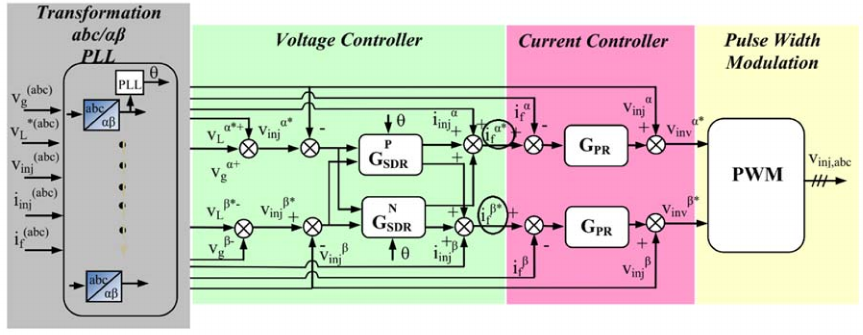
Figure 8. The structure diagram of double loop controller in the stationary